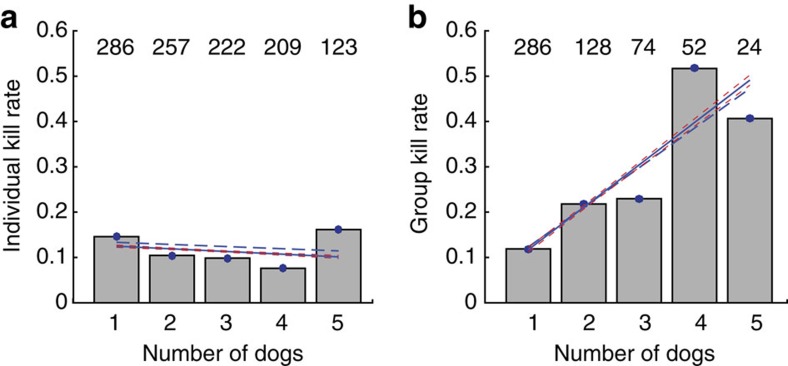
Relationship between kill rate and number of dogs running simultaneously.(a) Kill rate for individual chases and (b) group kill rate (DCs). (a) Number of chases identified as ending in kill divided by total number of chases within each group size (chases evaluated automatically as independent event, kill assumed if displacement of the dog conducting the chase is <50 m 5 min after the end of the run; total number of chases analysed, n=1,097). (b) Number of kills in DC (could be more than one in a DC) divided by total number of DCs within each group size (kills identified manually by four reviewers (at least three had to agree); total SDCs, n=286; total MDCs, n=278). Regression line (dashed blue line), weighted regression line based on number of observations in category (solid blue line) and curve fitting confidence interval to weighted regression line (dashed red line). Number of chases analysed in each group size displayed above histogram. Note: results in group size of 1 in a and b are theoretically identical (difference due to manual and automatic classification), and there were no successful chases for a group size of 6.